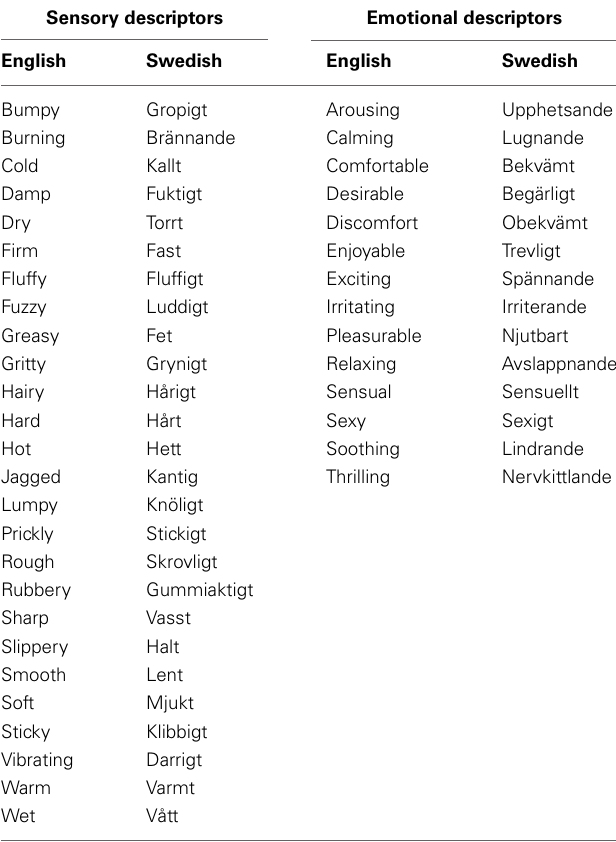
Table 1 | The list of sensory and emotional descriptors constituting the